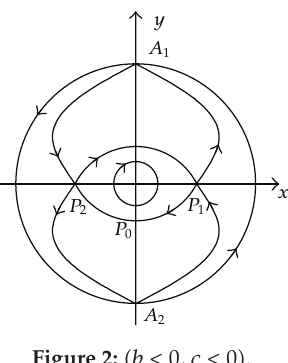
Figure 2: (cid:6) b < 0, c < 0 (cid:7) .